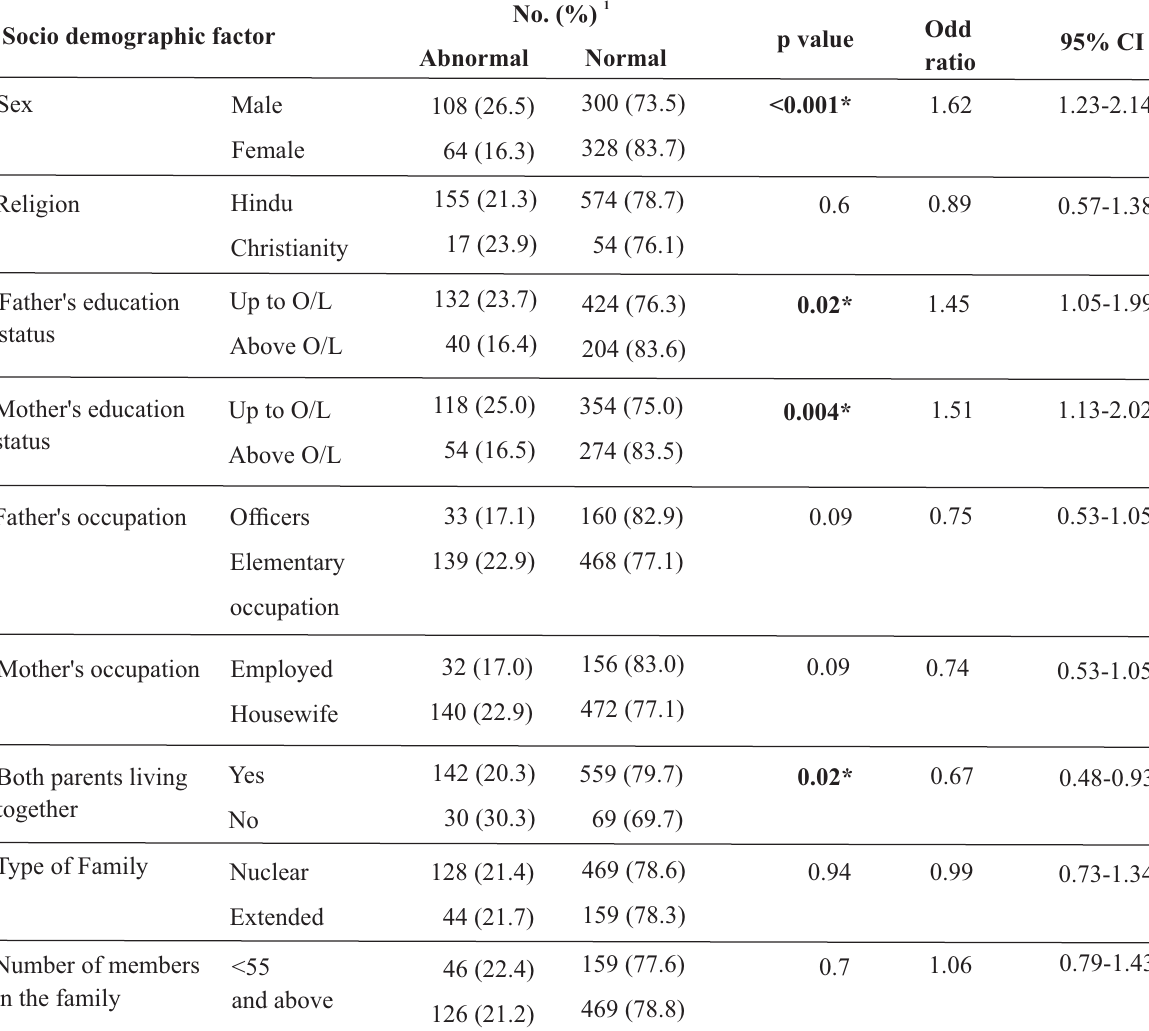
Table 2: Relationship between mental health status and socio demographic factors Socio demographic